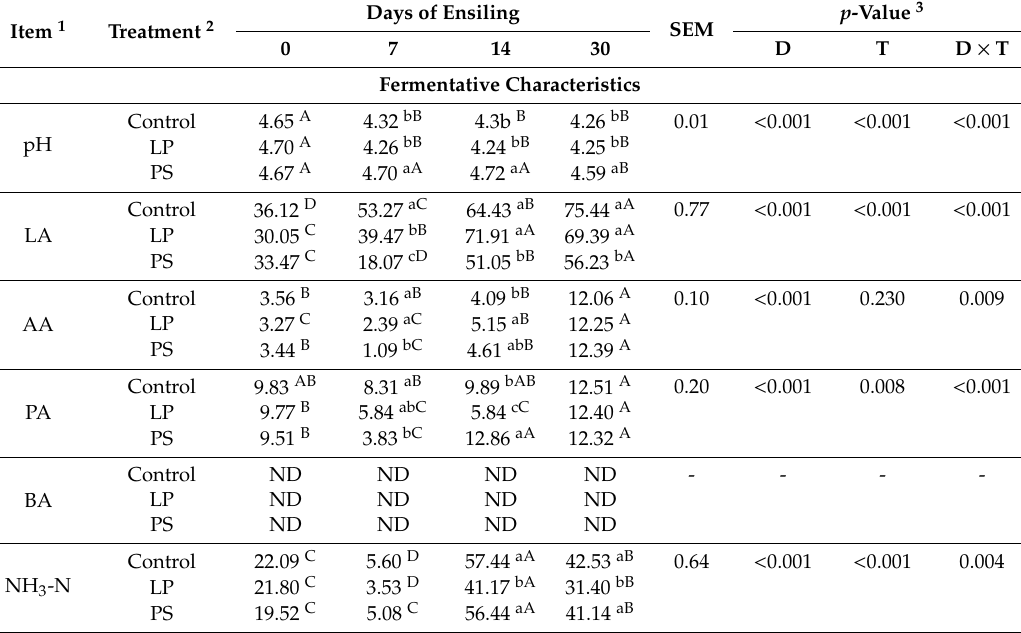
Table 3. Changes in fermentative characteristics during ensiling of total mixed ration (TMR)